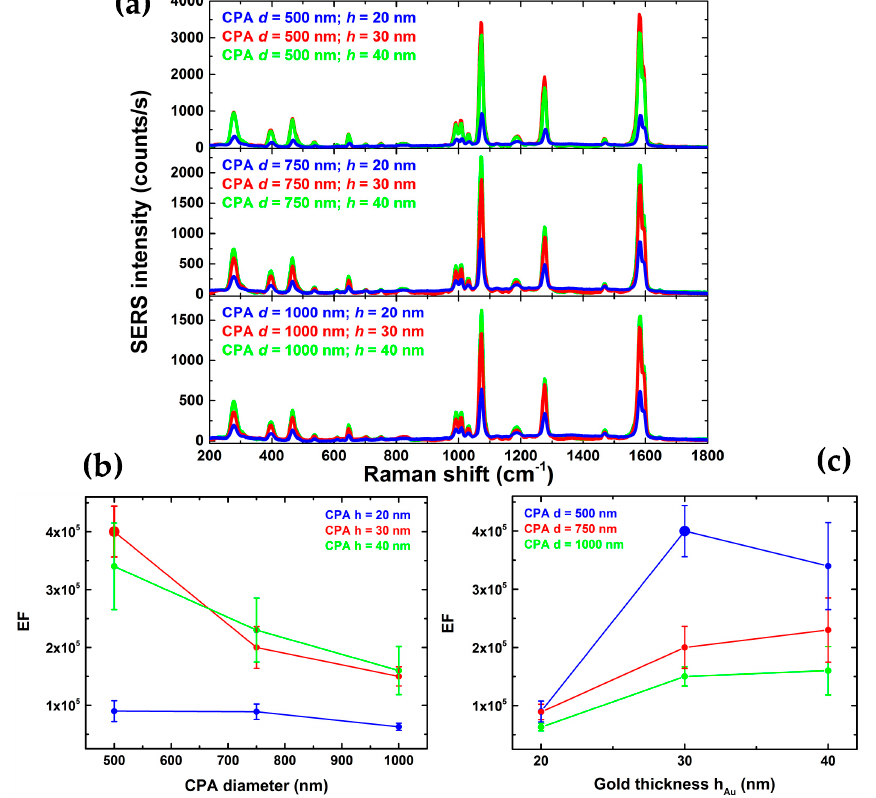
Figure 4. ( a ) Average BPT SERS spectra of 49 acquisitions, for the considered substrates: hexagonally closely packed arrays of PS nanospheres—CPA—with different diameters ( d = 500, 750, 1000 nm), and different gold films ( h = 20, 30, 40 nm). Measured enhancement factor for the different analysed geometry as a function of the CPA diameter ( b ) and gold layer thickness ( c ).